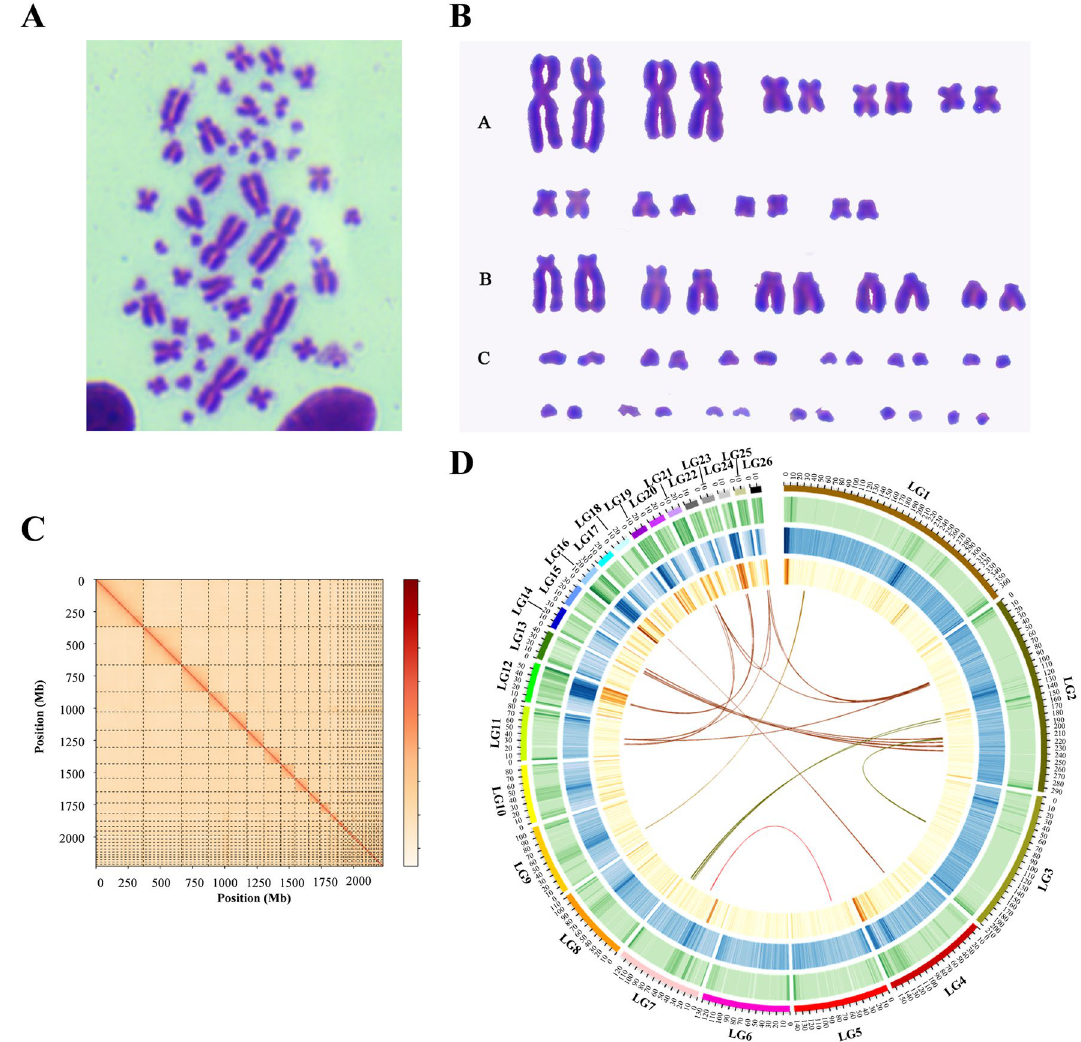
Figure 2. Chromosome-scale genome assembly and genomic features of the Asian yellow pond turtle. ( A ) and ( B ) Karyotype of the Asian yellow pond turtle from spleen (2n = 52). Group A is metacentric chromosome and submetacentric chromosome, group B is subtelocentric chromosome and telocentric chromosome, and group C is microchromosome. ( C ) Chromosomal interaction maps. The color from light to dark indicates an increase in the interaction intensity. The abscissa and ordinate indicate their N*bin position in the genome. The 26 squares represent the constructed 26 chromosomes of Asian yellow pond turtles. ( D ) Circos atlas of the chromosomal genome of the Asian yellow pond turtle. From outer to inner circles: (I) Asian yellow pond turtle chromosomes; (II) Distribution of GC content across the genome; (III) Repetitive sequence coverage; (IV) Gene density across the genome; and (V) Chromosome collinearity, with each line joining internal syntenic families were shared by five TSD turtles (Fig. 4B). Among these, 735 M. mutica specific, 312 T. scripta specific, 485 P . megacephalum specific, 381 C . mydas specific and 347 C . picta specific gene families were also identified (Fig. 4B). The ML phylogenetic tree based on an orthologous set of 5134 single-copy coding genes indicated that M . mutica was most closely related to T . scripta , C . picta and P . megacephalum , and turtles were the sister group of crocodilians and birds, consistent with a previous investigation based on the draft genomes of C . mydas and P . sinensis (Fig. 4C) 25 . Molecular clock analysis with divergence time constraints based on fossil records revealed that lizard-snake-tuatara clade diverged from the bird-crocodilian-turtle clade at approximately 267.0–312.3 Mya, and turtles separated from the ancestor of archosaurians approximately 250.4 Mya with 95% confidence intervals between 241.4 and 265.0 Mya, and P . sinensis diverged from other TSD turtles approximately 172.4 Mya (124.4–221.2 Mya), while M . mutica divided from T . scripta , C . picta and P . megacephalum approximately 79.3 Mya (70.9–88.7 Mya) (Fig. 4C). Positive selection analysis involved in sex control. To further elucidate the potential genetic basis of sexual dimorphism and gonad development, we examined the single-copy orthologs of six turtles ( M. mutica , T . scripta , C. mydas , C. picta , P. megacephalum and P. sinensis ) to detect some key pathways or genes under positive